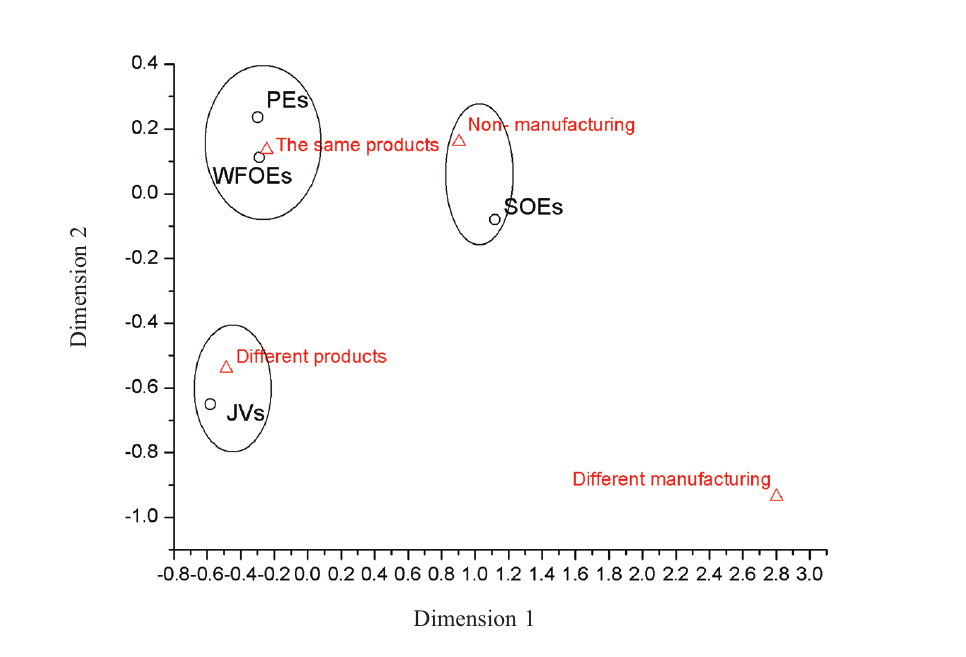
Fig. 6. Positioning maps between investment sector and enterprise